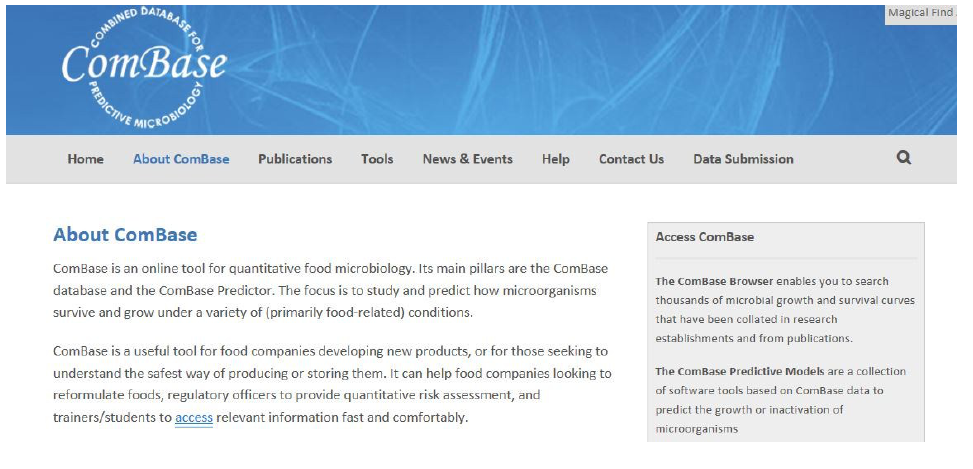
Figure 6. ComBase screen.